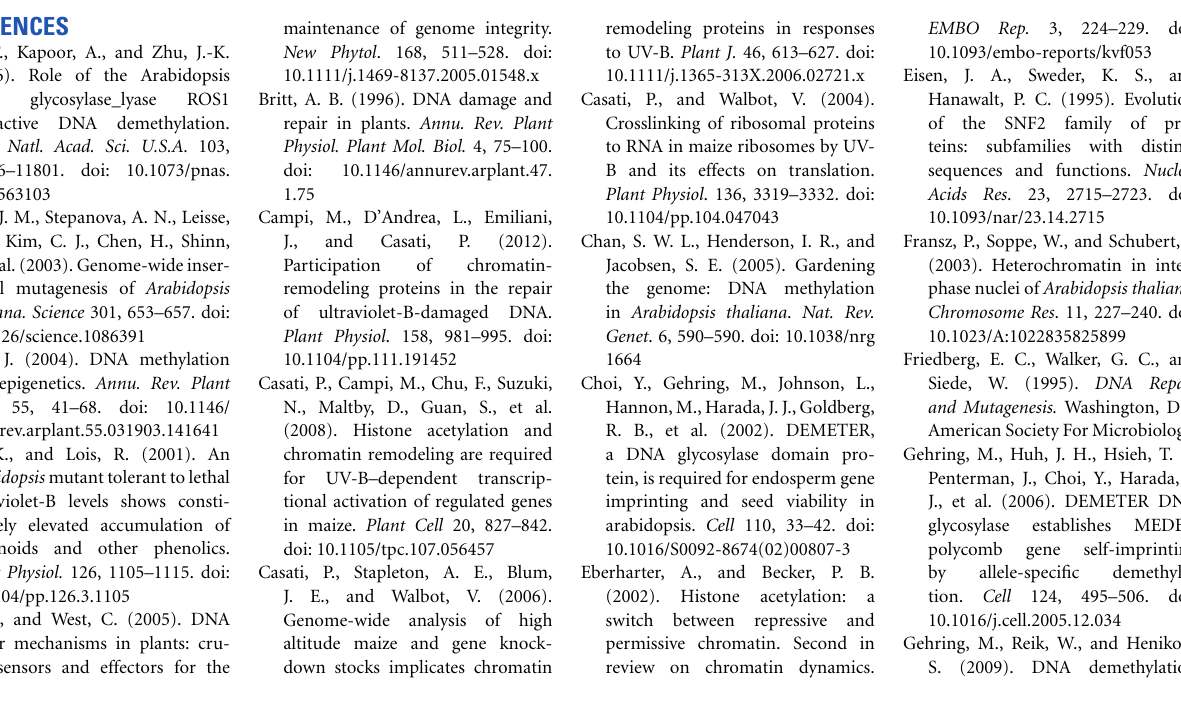
Figure S5 | Phenotypes of ddm1 mutants. (A) Images of 4-weeks-old Col0 and SALK_093009 plants. (B) Images of 6-weeks-old Col0 and SALK_093009 plants. (C) Analysis of AtMu1 transposase expression in Col0 and SALK_093009 plants. Transcript levels were evaluated by RT-PCR followed by agarose gels on cDNAs obtained from RNA extracted from the mutant or WT lines. Figure S6 | Relative expression of DNA repair transcripts by RT-qPCR in Col0, ddm1 ( ddm1_000509 line) and ros1 ( ros1_045303 line). Levels of UVR2 , UVR3 , UVR7 , UVH1 , UVH6, and OGG1 were assayed in arabidopsis plants that were irradiated with UV-B for 4h (UV-B) or were kept under control conditions without UV-B (control). Expression values are relative to the values in Col0 plants under control conditions in the absence of UV-B. The CPK3 transcript was used as a control. Data show mean values ± S.E.M. of at least three independent experiments. Figure S7 | Relative expression of DNA glycosidase transcripts by RT-qPCR in ros1 plants. Levels of DML2 , DML3 and DME1 were assayed in arabidopsis plants that were irradiated with UV-B for 4h (UV-B) or were kept under control conditions without UV-B (control). Expression values are relative to the values in Col0 plants under control conditions in the absence of UV-B. The CPK3 transcript was used as a control. Data show mean values ± S.E.M. of at least three independent experiments. Table S1 | Primers used for identification of homozygous mutant lines. Table S2 Primers used for